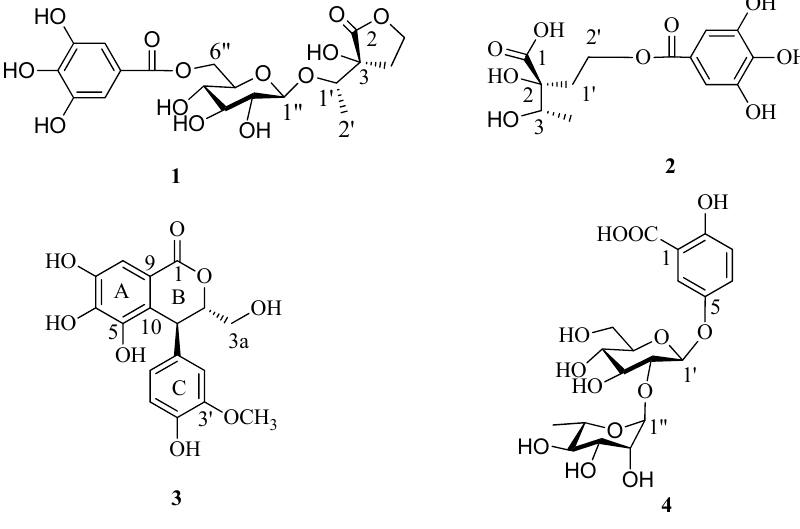
Figure 1. Structures of compounds 1 – 4 .